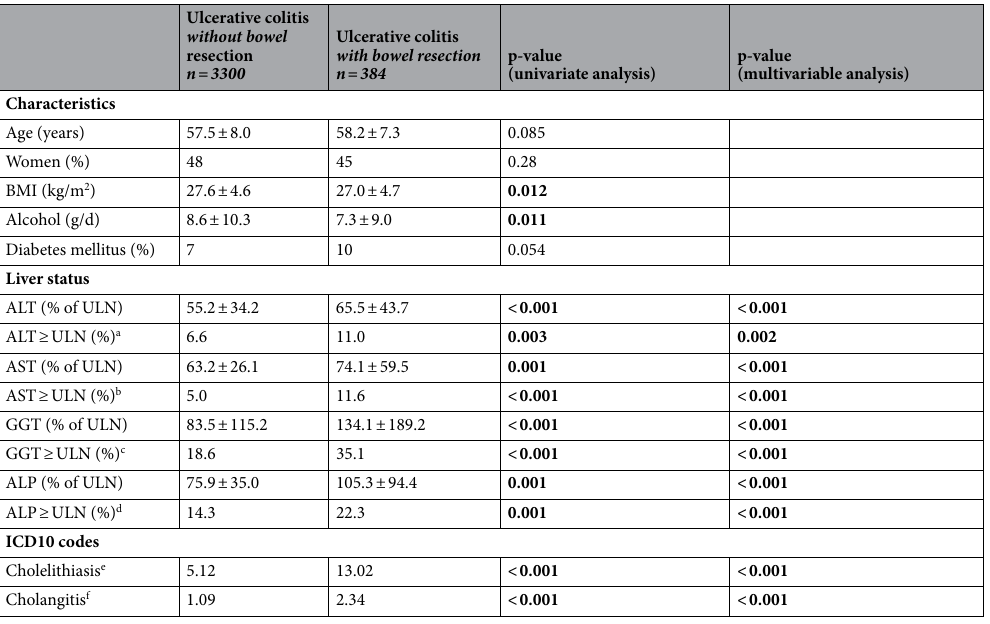
Table 2. Comparison of UK Biobank cohorts with ulcerative colitis that did/did not undergo bowel resection. Quantitative measures are expressed as mean with standard deviation or relative frequency (%). All analyses were adjusted for age, sex, BMI, presence of diabetes mellitus, and mean alcohol consumption. p-values <0.05 are highlighted in bold. a unadjusted OR = 1.73[1.21–2.48], adjusted OR = 1.83[1.25–2.67]; b unadjusted OR = 2.49[1.73–3.59], adjusted OR = 2.45[1.69–3.53]; c unadjustedOR = 2.36[1.86–3.00], adjusted OR = 2.64[2.06–3.38]; d OR = 1.71[1.31–2.24], adjusted OR = 1.90[1.43–2.54]; e unadjusted OR = 3.20[1.85–5.54], adjusted OR = 2.89[2.05–4.07]; f unadjusted OR = 2.77[1.98–3.88], adjusted OR = 3.19[1.84–5.52].